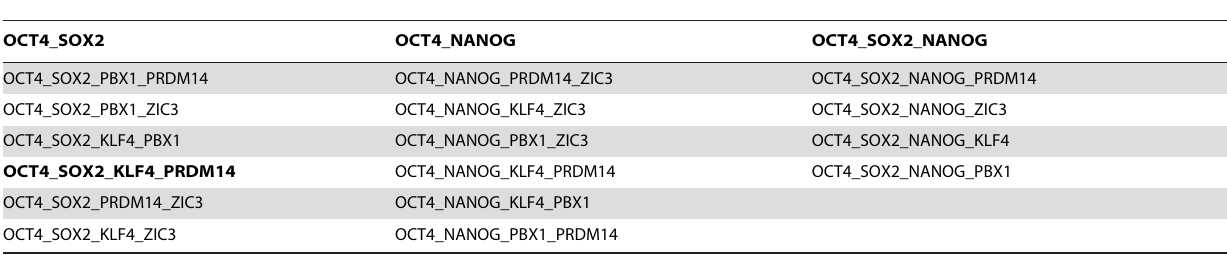
Table 3. Representative candidate reprogramming recipes.